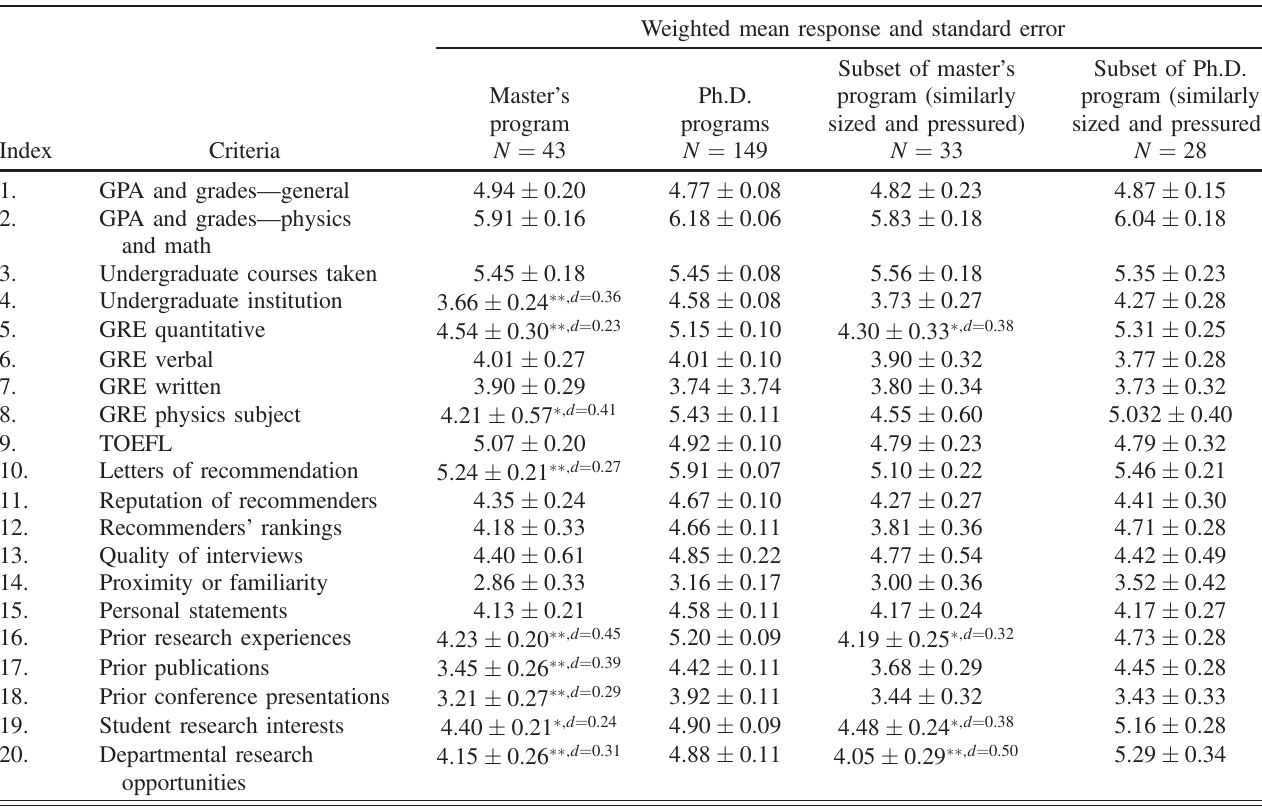
The Table I in the appendix provides weighted mean response and standard errors for each admission criteria in master ’ s and Ph.D. programs. The effect size for all criteria that were found to be statistically significantly different in the comparison of weighted mean responses are indicated. We used Cliff ’ s delta (d) as the estimate for effect size. I. Table of weighted mean response and standard errors for each admission criteria in both master ’ s and Ph.D. programs (* p < 0 . 05 , ** p < 0 . 01